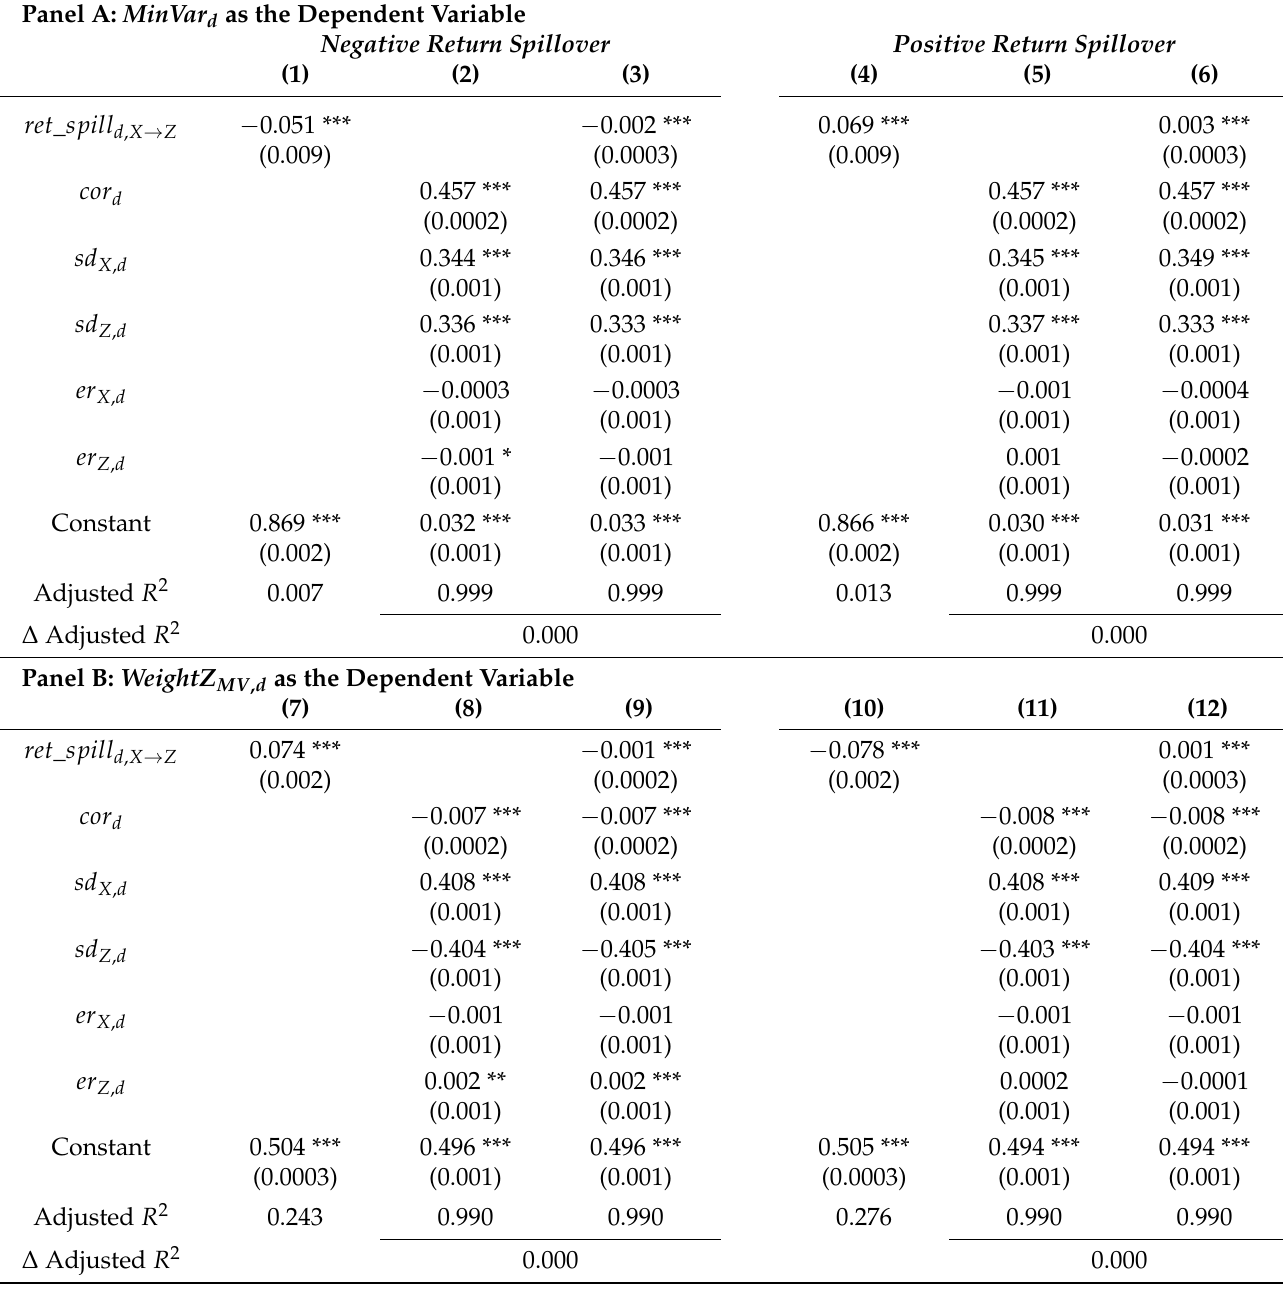
Table 1. Effects of return spillovers on the minimum variance portfolio formed by the same frequency returns. This table presents the results from the regressions of the standard deviation (Panel A) and the weight of the spillover-receiving asset (Panel B) of the daily minimum variance portfolio on daily return spillover ( ret _ spill d , X → Z ), controlling for the daily correlation ( cor d ), daily standard deviation, and expected returns of the spillover-giving asset X ( sd X , d and er X , d ) and the spillover-receiving asset Z ( sd Z , d and er Z , d ). We use “daily” for the illustration purpose; the results also apply to any other frequency. The last row in each Panel presents the difference between Adjusted R 2 of the full model and the restricted model without spillovers. Standard errors are in parentheses. *, **, and *** denote significance levels of 10%, 5%, and 1%,